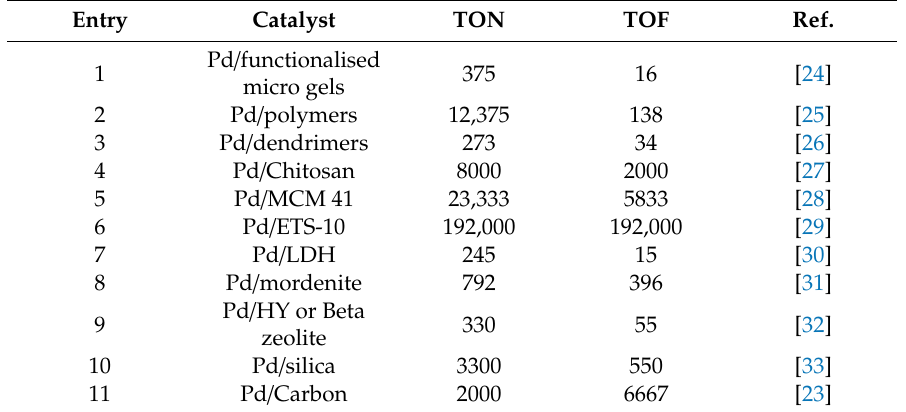
Table 1. Heterogeneous catalyst systems applied in Heck reactions with their TONs and TOFs. Entry